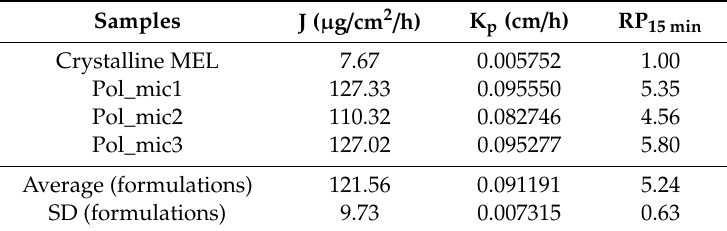
Figure 11. In vitro permeability study of MEL-loaded polymeric micelles in triplicate compared to crystalline MEL; data are means ± SD ( n = 3 independent formulations). Table 10. Results of in vitro permeability study. Flux (J); permeability coefficient (K p ) and relative